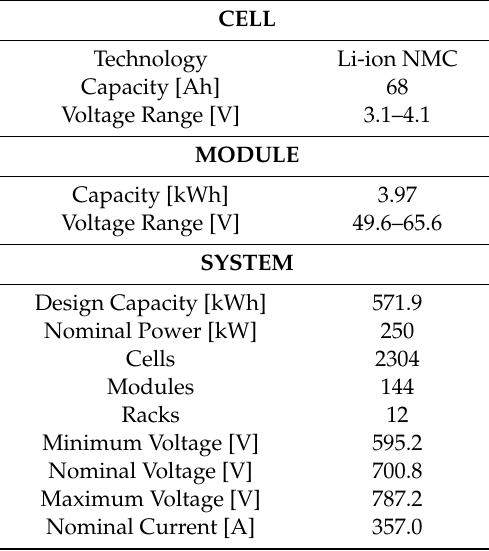
Table 1. Battery pack essential datasheet.